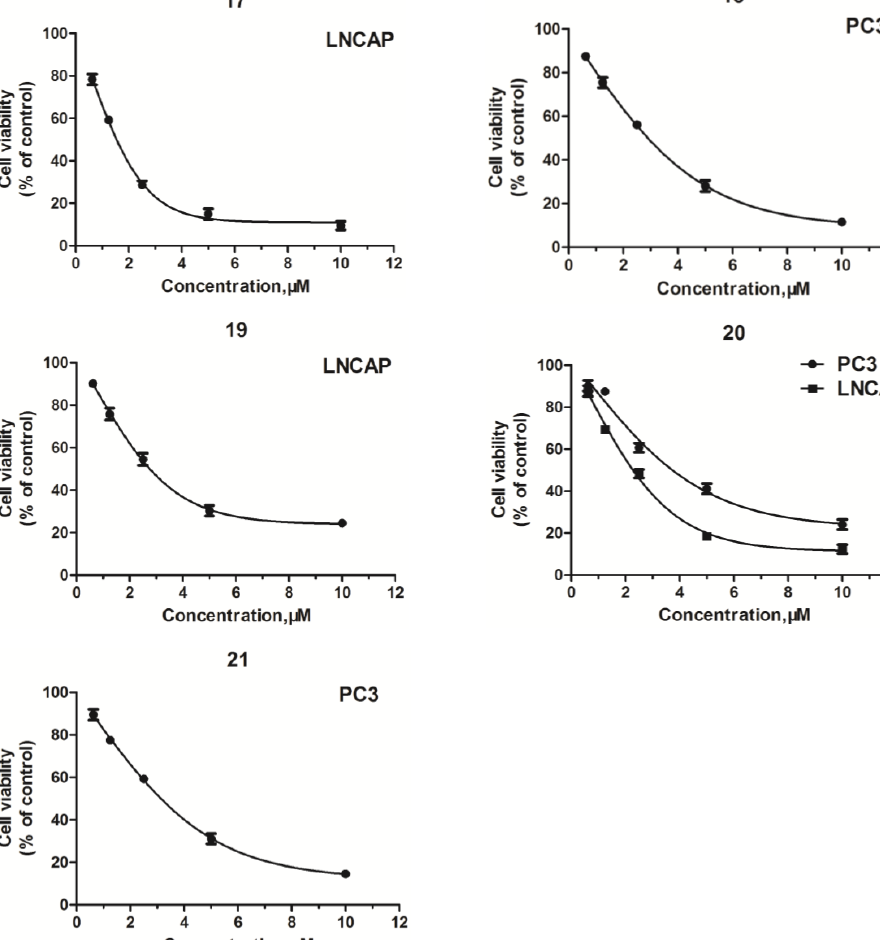
Figure 2. Arylpiperazine derivatives containing the saccharin moiety inhibited cell viability (percent relative to control) in the prostate cell lines PC-3, LNCaP, and DU145. All of the cells were exposed to escalating concentrations of arylpiperazine derivatives respectively for 24 h, and the cell viability was detected by CCK-8